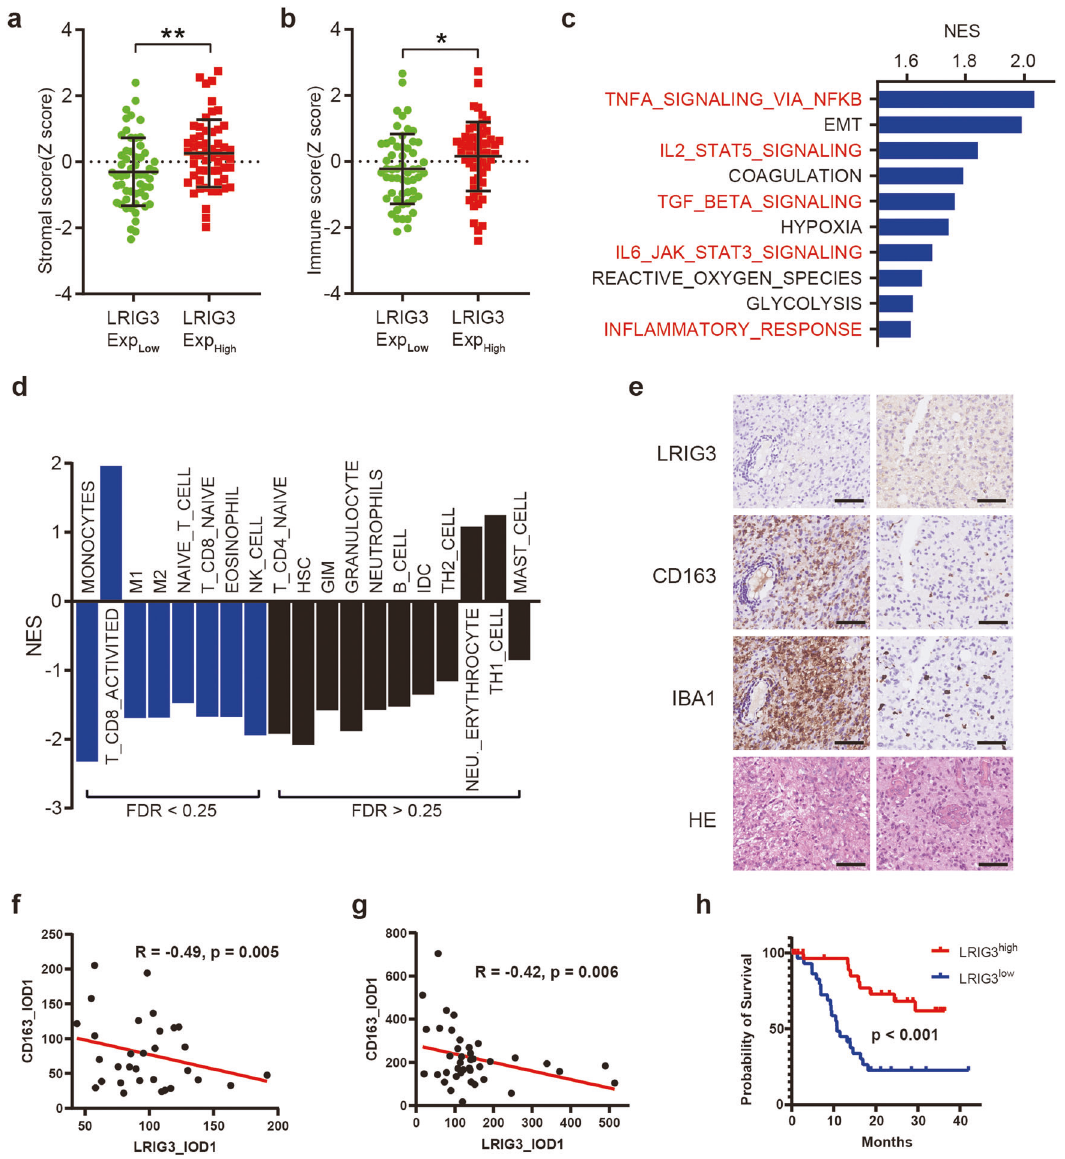
Fig. 1 LRIG3 expression is negatively correlated with tumor-supportive TAMs in human GBM and informs good prognosis of GBM patients. a , b The stroma score ( a ) and immune score ( b ) of LRIG3-High-expression and LRIG3-low-expression patients in the TCGA GBM database. The stroma and immune scores were determined based on expression data (Yoshihara et al., 2013). Unpaired student ’ s t test. c GSEA analysis based on KEGG gene sets and TCGA GBM database. d GSEA analysis for various types of immune cells in LRIG3-High-expression and LRIG3-low-expression patients in TCGA GBM database. e Representative images of HE staining and the low- and high-expression levels of LRIG3, CD163, and IBA1 in human GBM tissue microarrays. Scale bar, 50 mm. f , g Correlation analysis between LRIG3 and CD163 expression in TMA of low grade (grade 2 and 3) glioma ( n = 31) ( f ) and GBM ( n = 40) ( g ). Pearson ’ s correlation test. h Kaplan – Meier survival curves of LRIG3- High-expression and LRIG3-Low-expression patients in TCGA GBM (Fig. 1e – g). Meanwhile, GBM with high LRIG3 expression predicted a better prognosis (Fig. 1h). In conclusion, these fi ndings indicated that high expression of LRIG3 was negatively correlated with enrichment of TAMs in GBM TME and predicted a great prognosis of GBM patients.